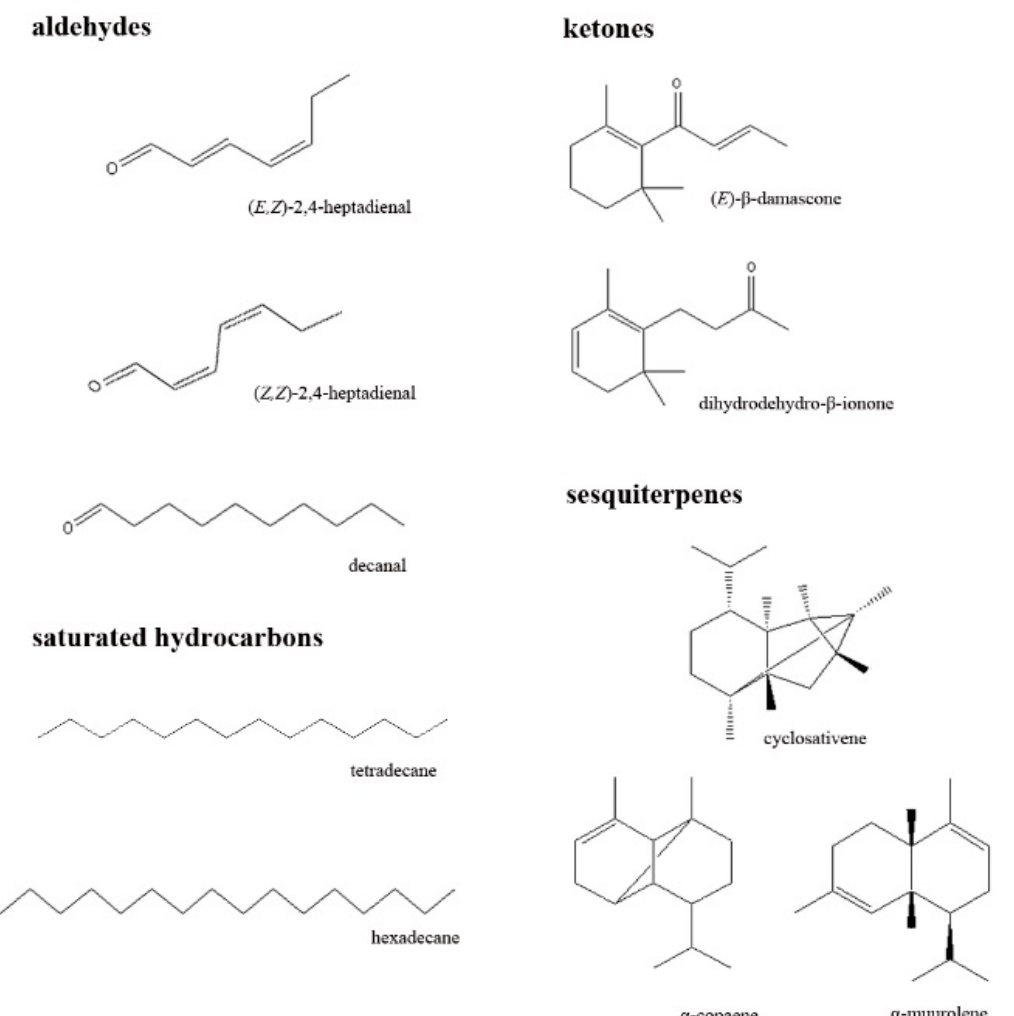
Figure 3. Volatile compounds responsible for differentiation of cv. Oblica from other analyzed olive leaves cultivars .